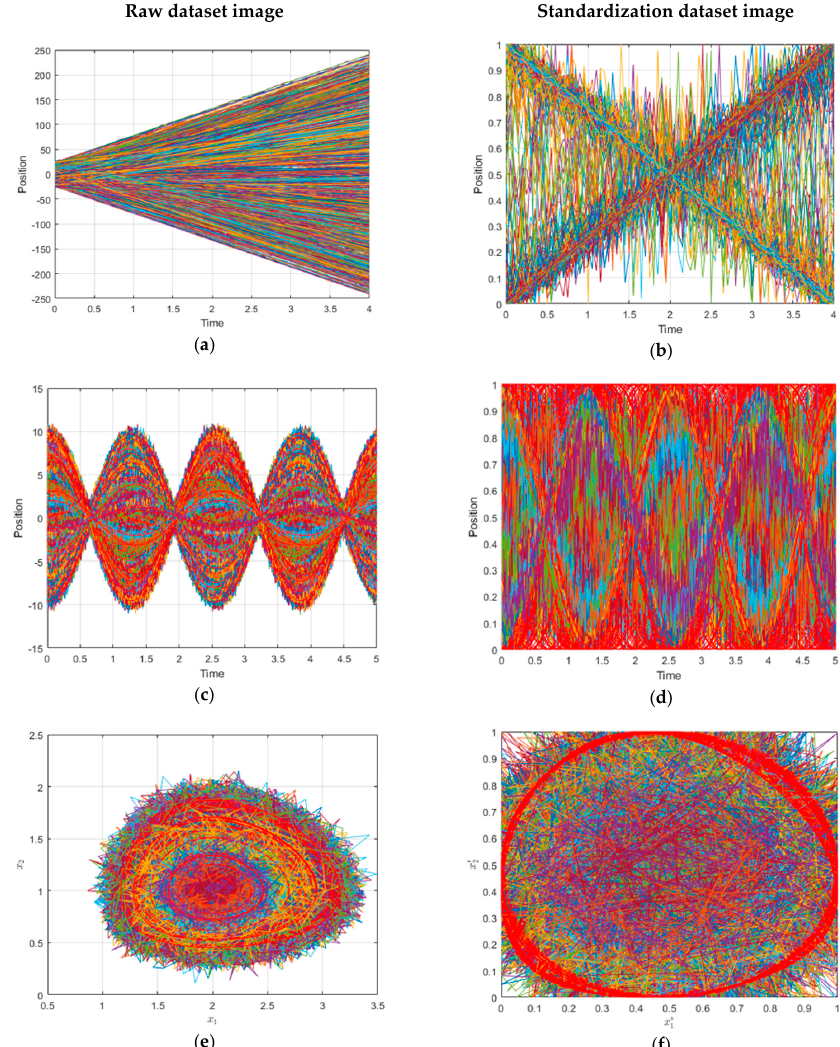
Figure 1. ( a , c , e ) a set of 10 3 ideal paths in real space with uniform rectilinear motion (URM), sinusoidal, and Volterra System. ( b , d , f ) a set of 10 3 paths in standardized space with URM, sinusoidal, and Volterra System.